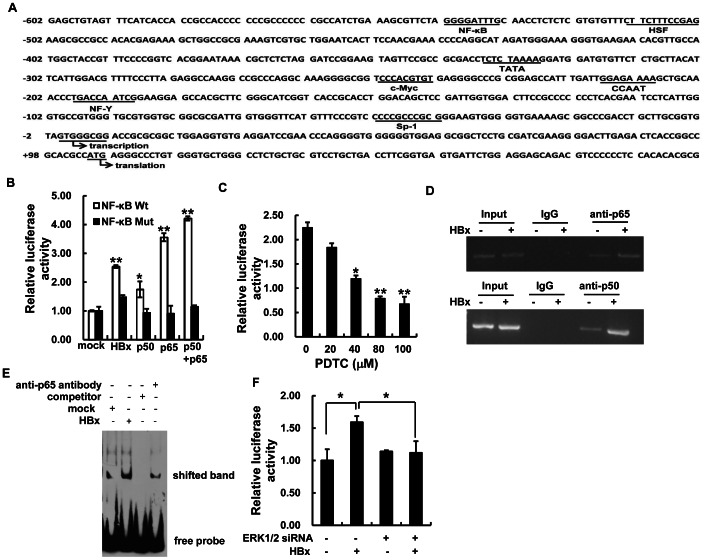
HBx up-regulates the expression of gp96 by activating NF-κB.(A) Sequence analysis of the human gp96 promoter using the online TFSEARCH program. The putative binding sites for several cis-acting elements are indicated. (B) Huh7 cells were co-transfected with the gp96 promoter luciferase reporter plasmid with a wild type or mutated NF-κB binding site and pcDNA3.1-HBx, pcDNA3.1-p50 and pcDNA3.1-p65 as the positive controls, or pEGFP-C1 as a mock. The relative luciferase activity was determined 48 h after transfection. The luciferase activity of the mock-transfected group was set as 1.0. (C) Huh7 cells were treated with the indicated concentration of PDTC after co-transfection with pcDNA3.1-HBx and the gp96 promoter luciferase reporter plasmid. The luciferase activity in untreated cells was used as a control. (D) CHIP analysis was performed with cross-linked cell fragments of Huh7 cells transfected with pcDNA3.1-HBx or mock plasmids. The immunoprecipitated DNA was analyzed by PCR using gp96 promoter-specific primers. (E) EMSA analysis was performed with nuclear extracts of Huh7 cells transfected with pcDNA3.1-HBx or mock plasmids. (F) Huh7 cells were co-transfected with pcDNA3.1-HBx, ERK siRNA and the gp96 promoter luciferase reporter plasmid. The relative luciferase activity was determined 48 h after transfection. The luciferase activity of the mock-transfected group was set as 1.0. Data are presented as the means ± SD from three independent experiments. *P<0.05 and **P<0.01 compared to the mock or control.